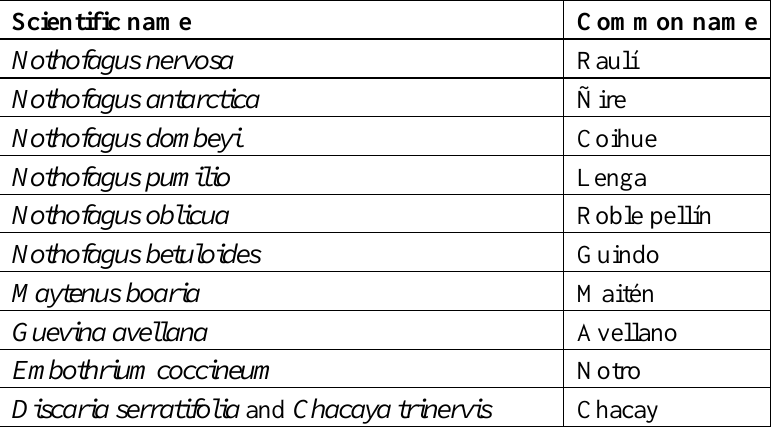
Table 5. List of the prevailing native species in Patagonian region.